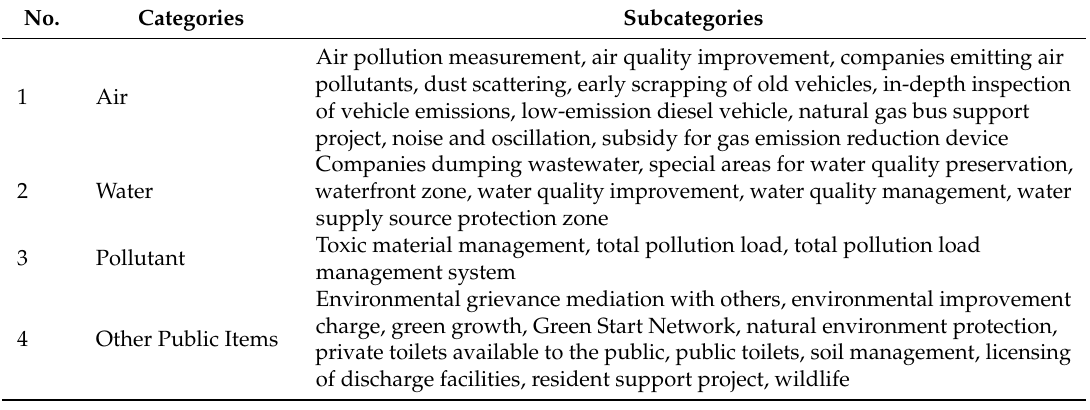
Table 1. Namyangju government’s categorization system for environmental complaints.